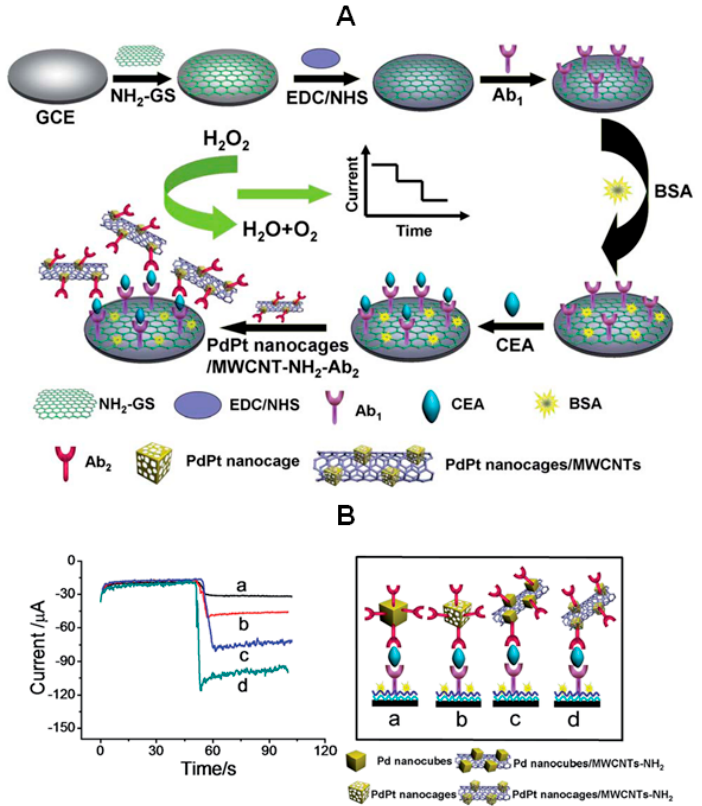
Figure 7. ( A ) Schematic illustration of the sandwich-type electrochemical immunosensor for carcinoembryonic antigen (CEA) using amino-functionalized multi-walled carbon nanotubes (MWCNTs) modified with PdPt nanocages with hollow interiors and porous walls as labels: Ab 1 immobilization on GCE modified with amine-functionalized graphene sheets (NH 2 -GS) and amperometric detection by addition of H 2 O 2 onto the PdPt/MWCNTs-Ab 2 -CEA-Ab 1 /graphene/GCE immunosensor; ( B ) Amperometric responses obtained with the developed immunosensor for the detection of 4 ng · mL − 1 of CEA using different signal labels: Pd nanocubes (a), PdPt nanocages (b), Pd nanocubes/MWCNT-NH 2 (c) and PdPt nanocages/MWCNT-NH 2 (d). Reprinted and adapted from [34] with permission.